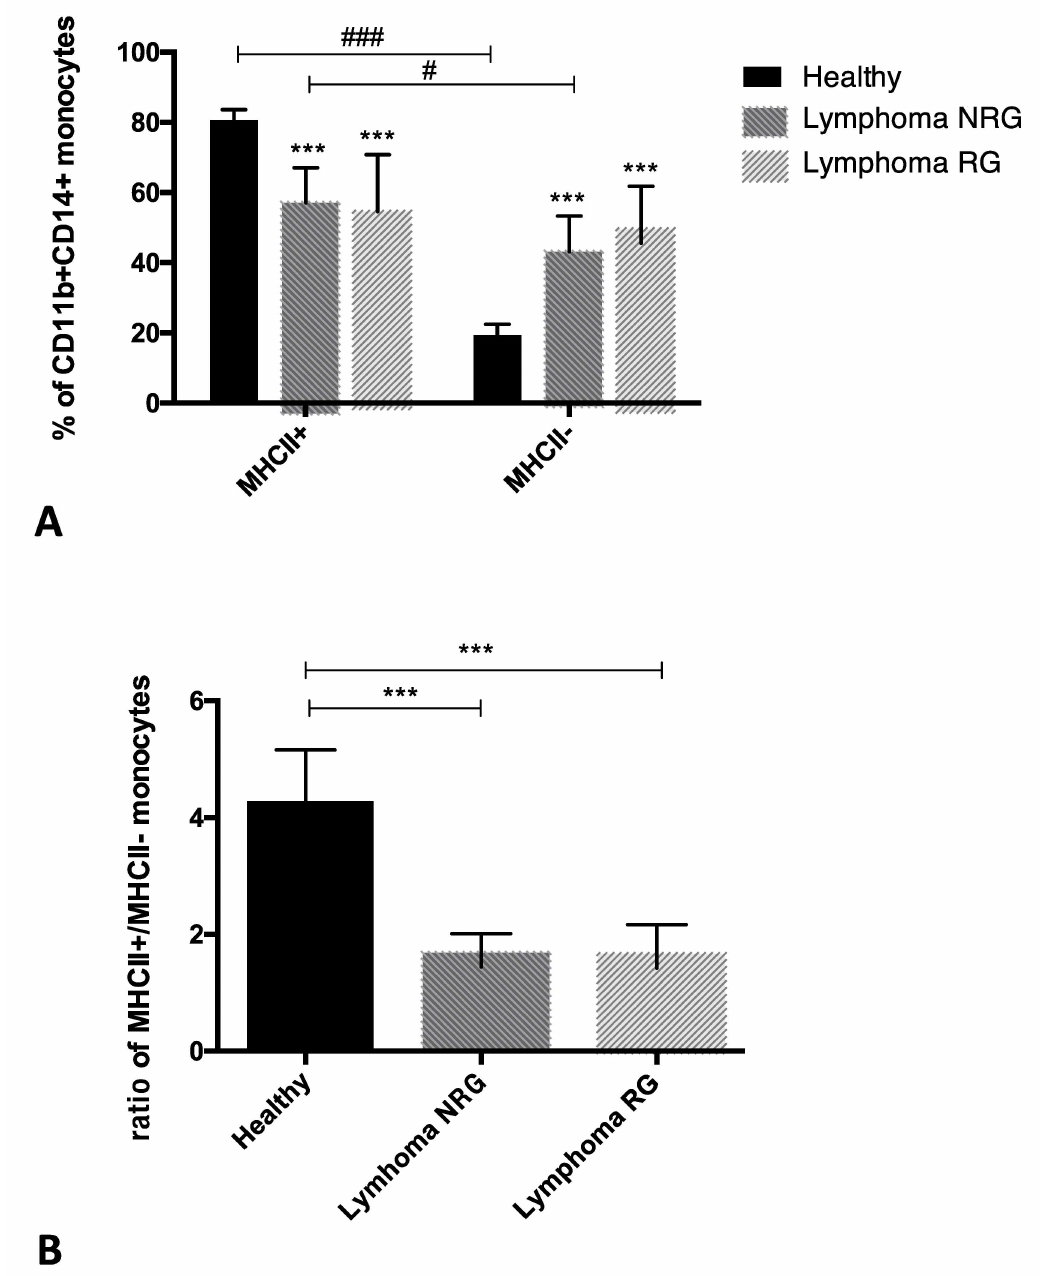
Figure 3. ( A ) The percentage of CD11b+CD14+ monocytes: MHCII+ and MHCII − , in the peripheral blood of healthy dogs ( n = 11) and dogs with lymphoma: not receiving any drugs (NRG, n = 10) and receiving glucocorticoids (RG, n = 8). Arithmetic mean ± standard deviation. Significant differences between the percentage of MHCII+ and MHCII − monocytes among each group: # p < 0.05, ### p ≤ 0.001 (Wilcoxon) and for the percentage of MHCII+ or MHCII − monocytes in comparison to healthy dogs: *** p ≤ 0.001 (no significant differences between dogs with lymphoma NRG and RG) (Kruskal–Wallis and post hoc Dunn analysis). ( B ) The results are shown as the ratio of CD11b+CD14+ monocyte percentages: MHCII+ to MHCII − . Arithmetic mean ± standard deviation. Significant differences between groups: *** p ≤ 0.001 (Kruskal–Wallis and post hoc Dunn